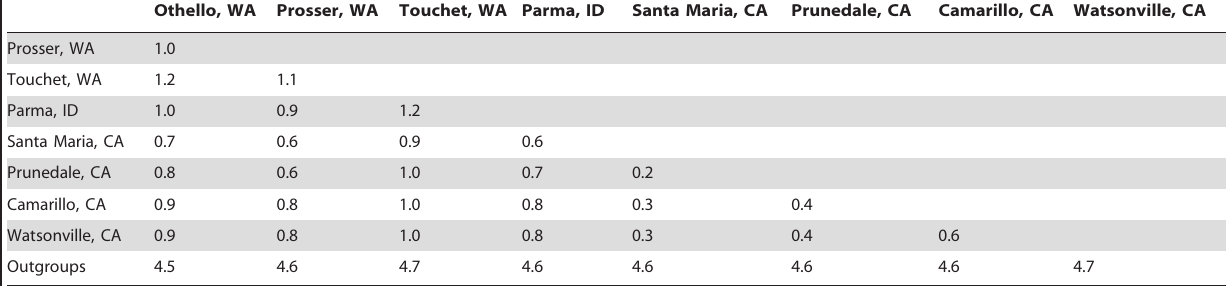
Table 8. Pairwise distances of L. hesperus populations and L. lineolaris/L. elisus (outgroups).